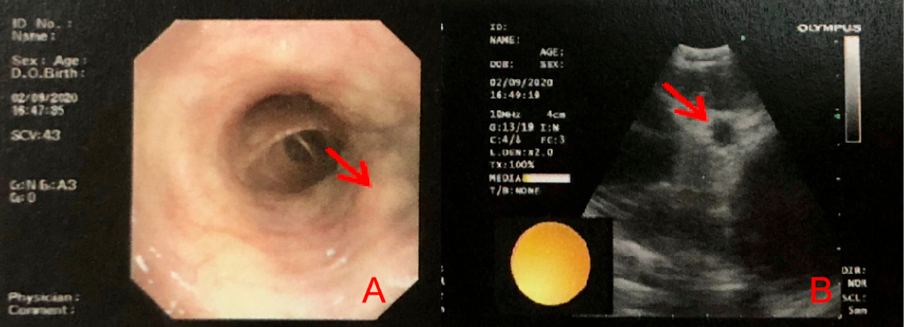
Figure 4. ( A ) Bronchoscopy shows multiple small nodules in the mucosa of the distal left main bronchus and the right middle bronchus. ( B ) Endobronchial ultrasonography shows enlargement of lymph nodes in 4L, 4R, 7, 11L, and 11R groups.